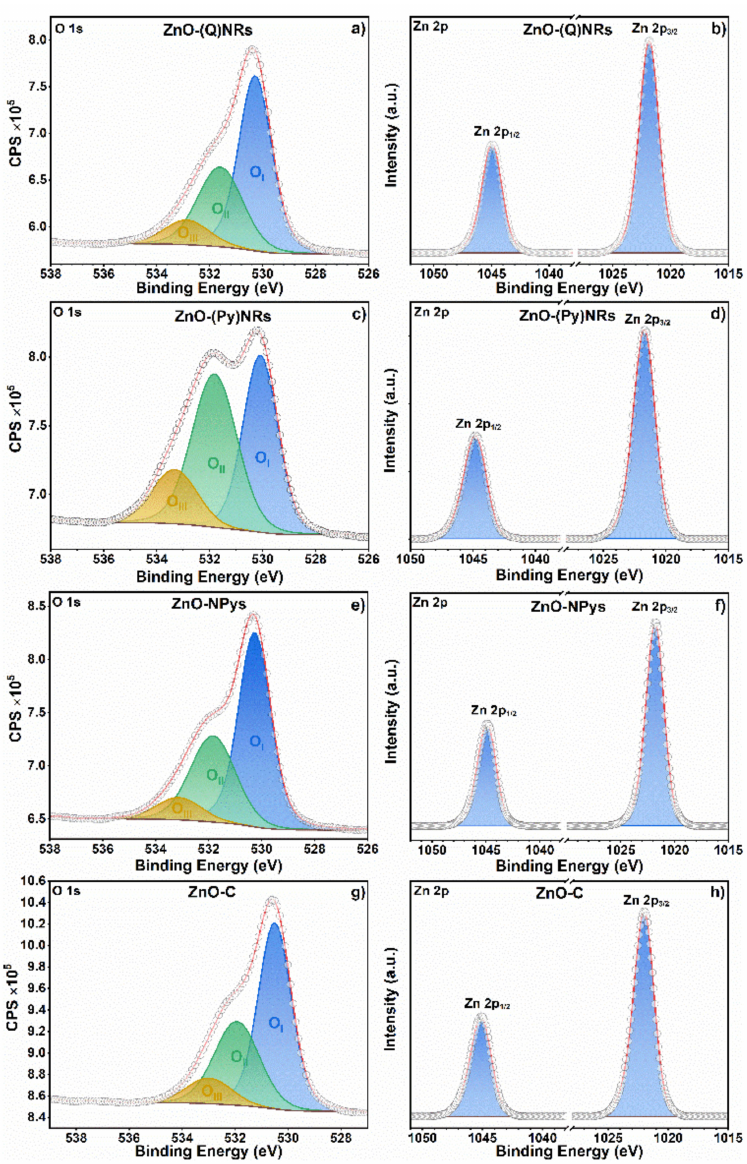
Figure 7. High-resolution XPS spectra of pristine ( a , b ) ZnO-(Q)NRs, ( c , d ) ZnO-(Py)NRs, ( e , f ) ZnO- NPys and ( g , h ) ZnO-C samples in the O 1s and background-subtracted Zn 2p spectral